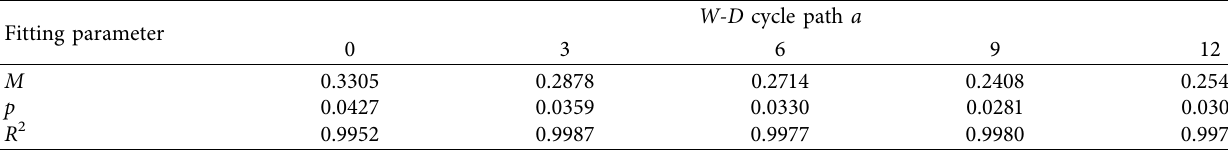
Table 9: Fitting parameters of λ and ε